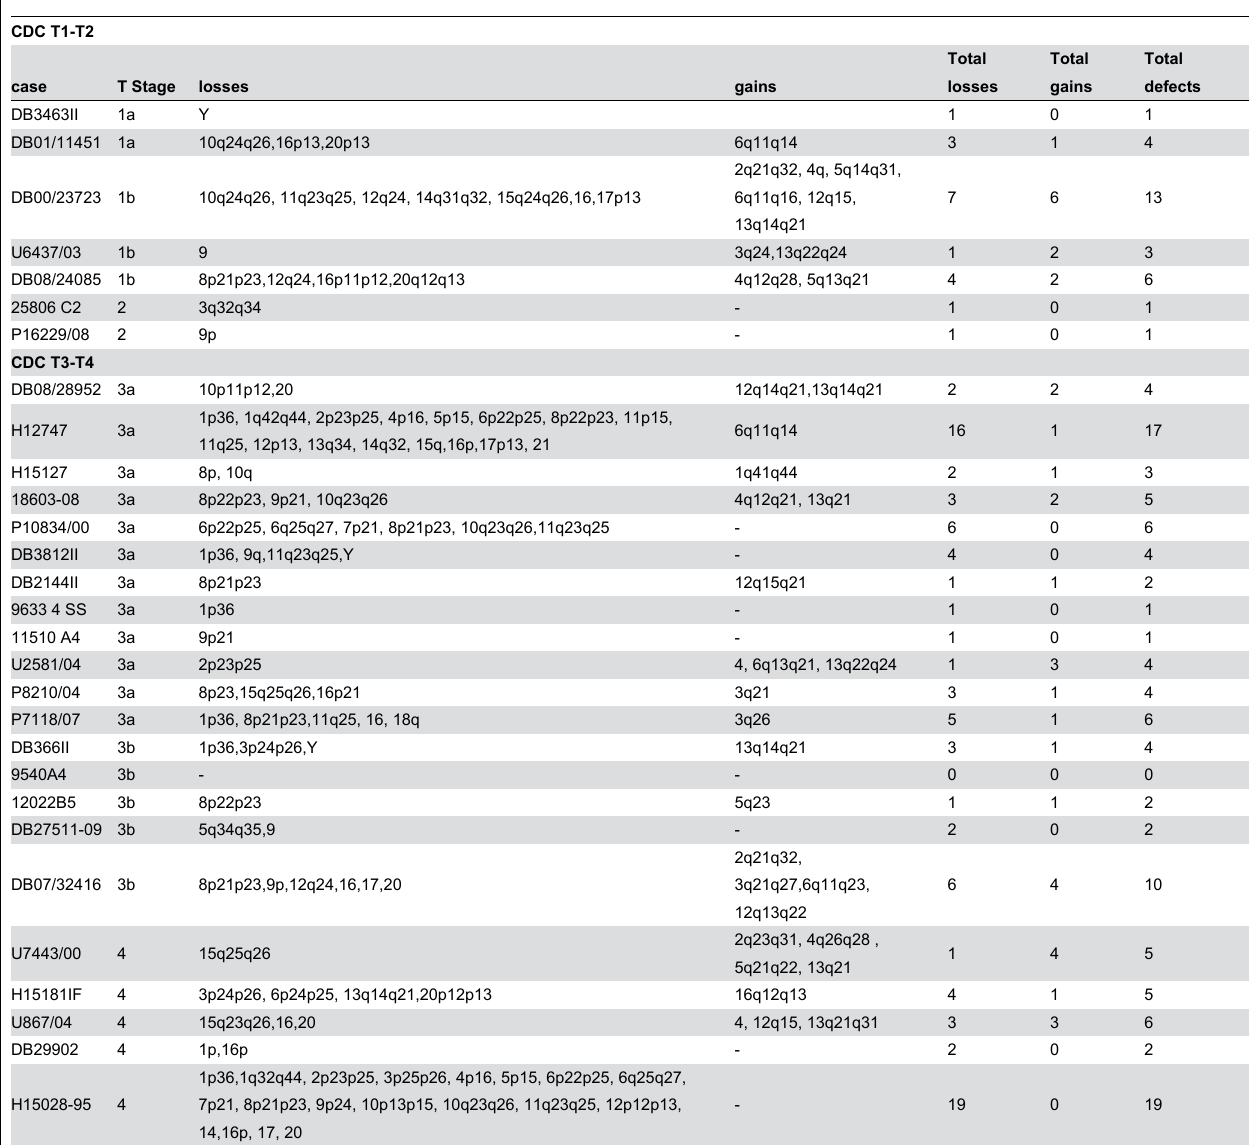
Table 2. CGH results of Collecting duct carcinomas (CDC): in detail.